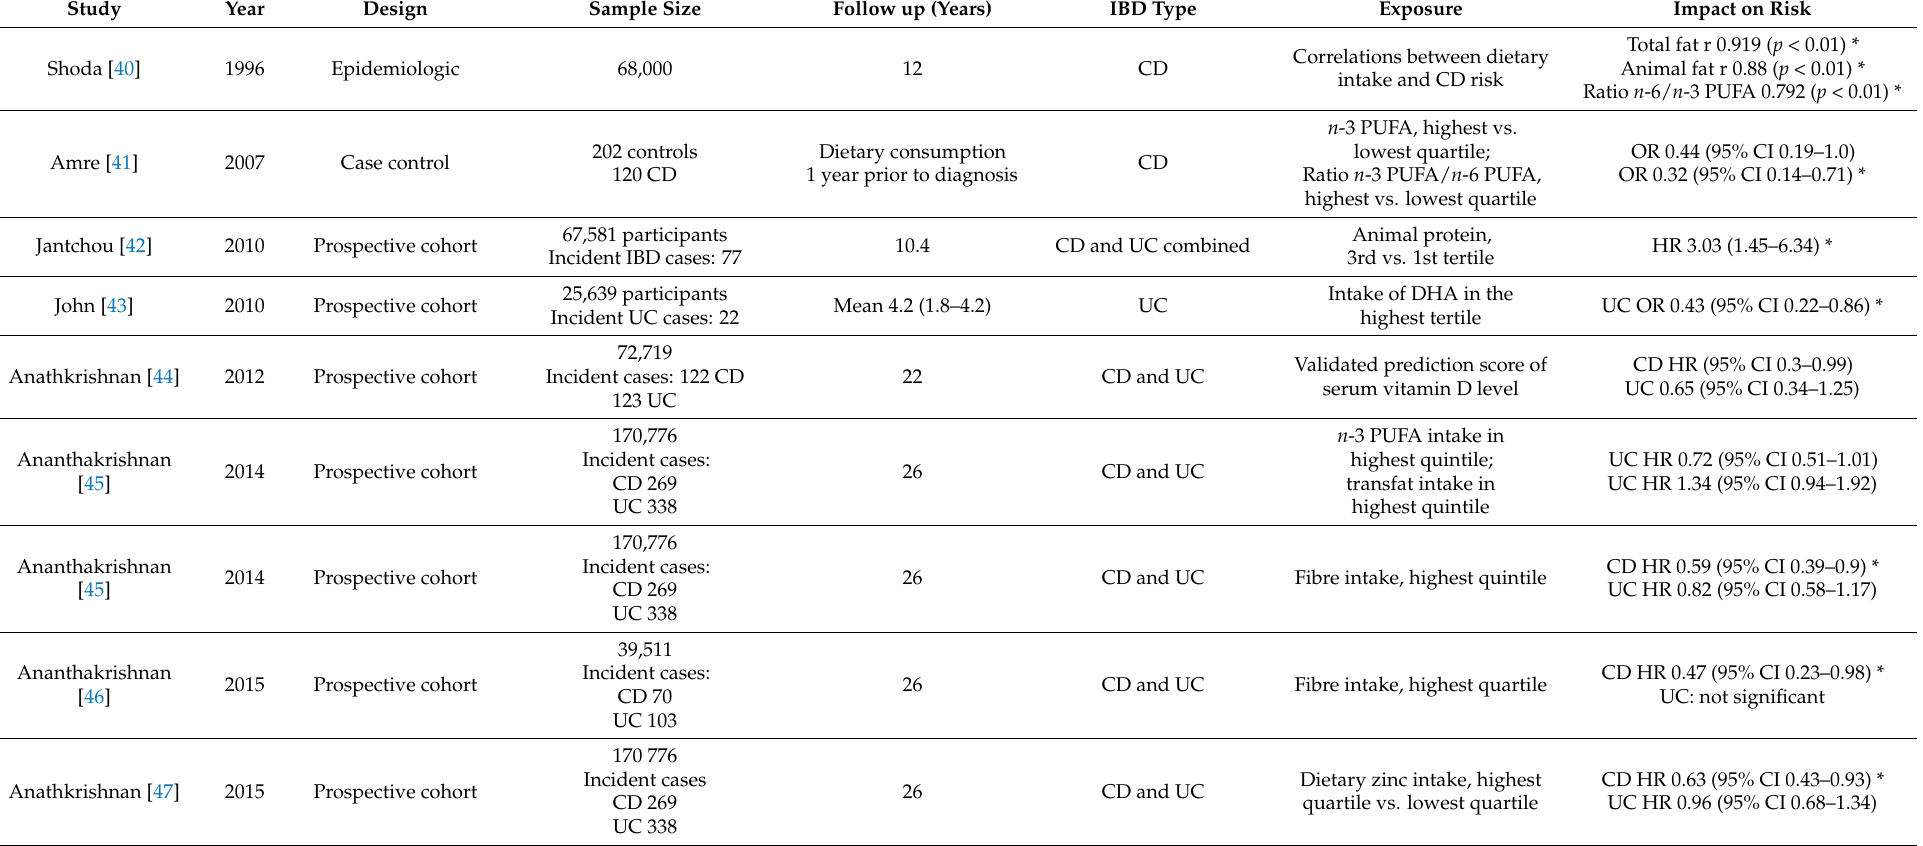
Table 1. Key epidemiological studies of the impact of diet on IBD